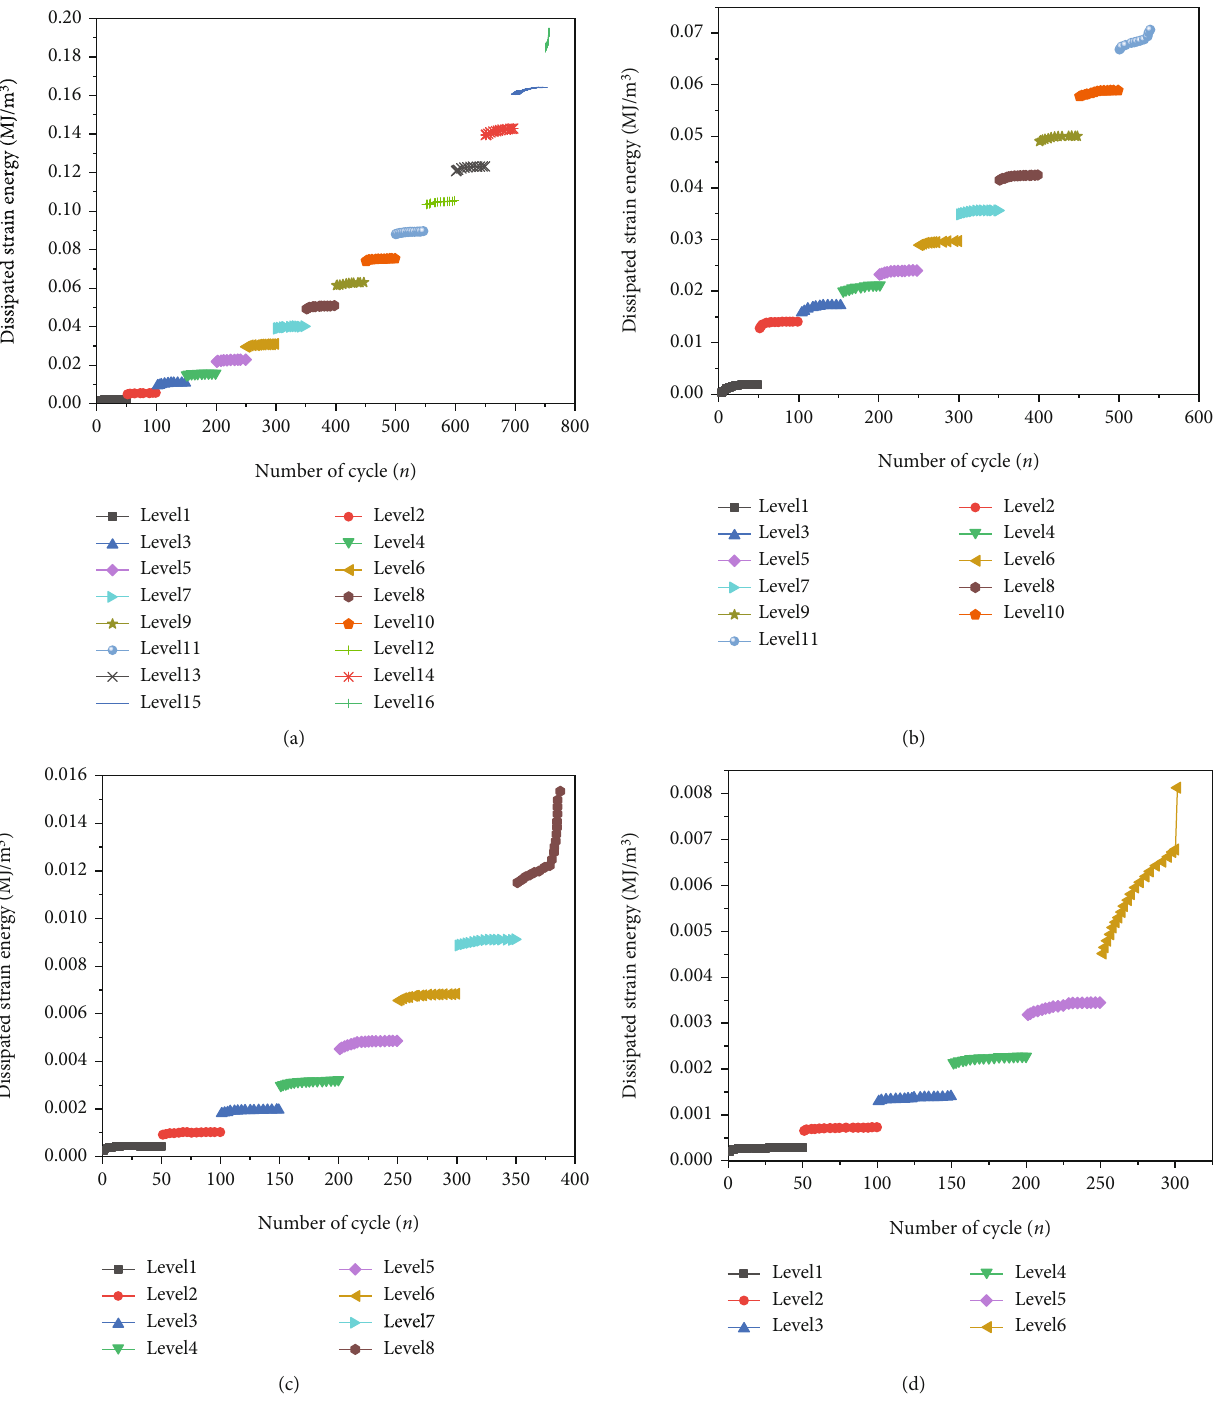
Figure 7: Relationship between the dissipated energy and cycle number ((a – d) Marble samples with di ff erent total natural fracture volumes of 0.68%, 1.03%, 1.53%, and 2.27%,